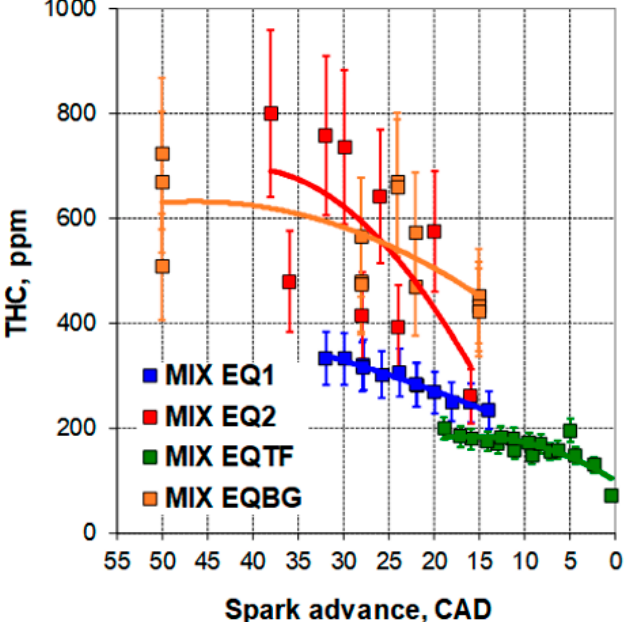
Figure 11. THC data for different SAs operation with minimum ignition energy at 1500 rpm and MAP 1250 mbar.